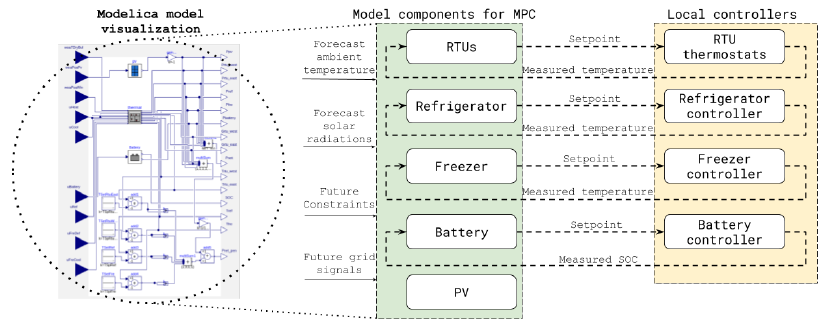
Figure 7. MPC model